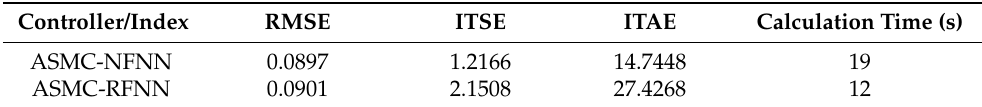
Table 3. Other performance index comparisons in simulation.